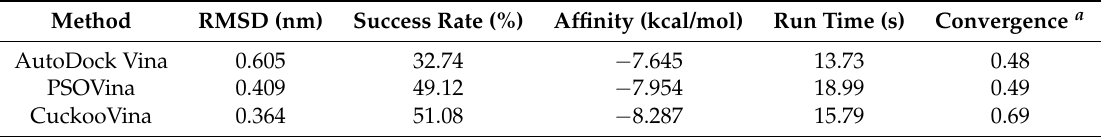
Table 2. Average performances of AutoDock Vina, PSOVina, and CuckooVina for docking the PDBbind 2012